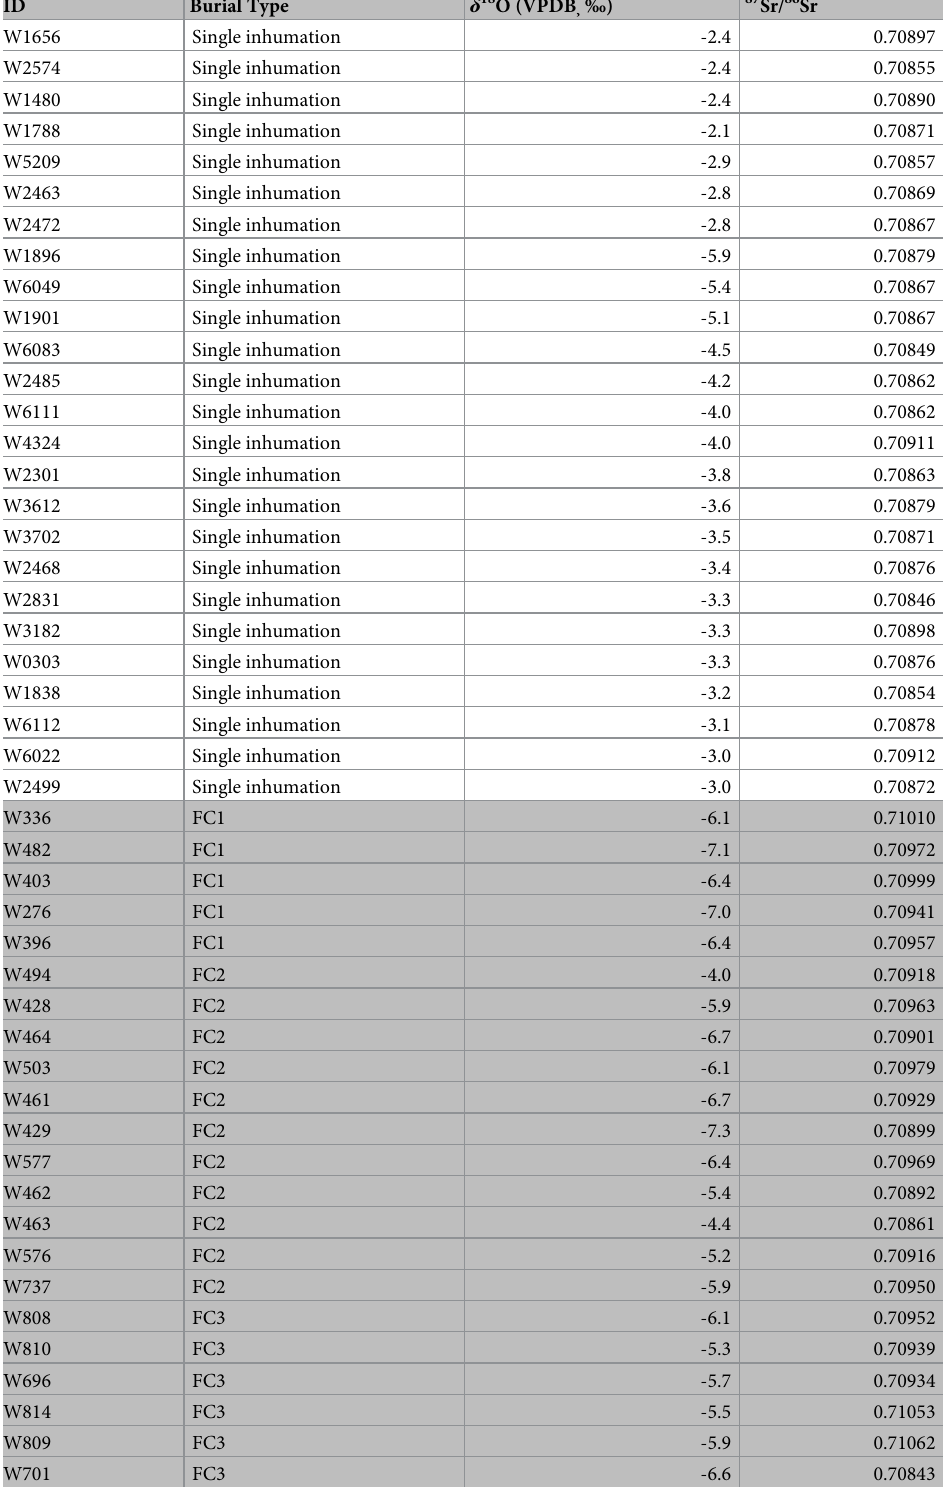
Table 3. Study data